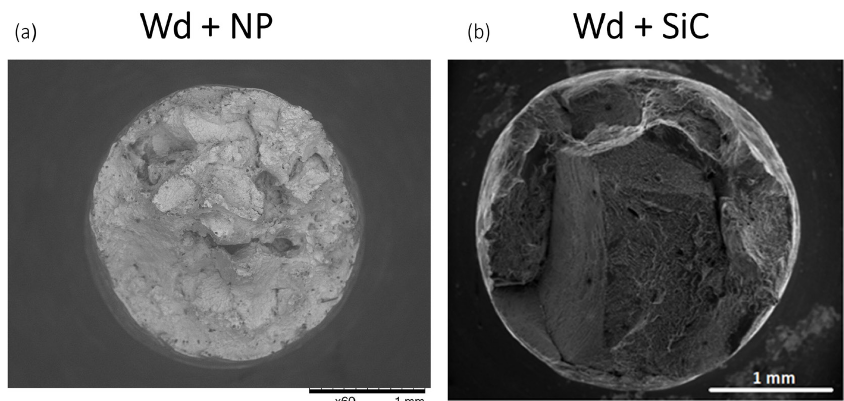
Figure 8. The fracture surface of the Ti-6Al-4V alloy creep tested at 500 °C and 319 MPa, (a) plasma nitrided (Wd + NP) and (b) SiC coated (Wd +